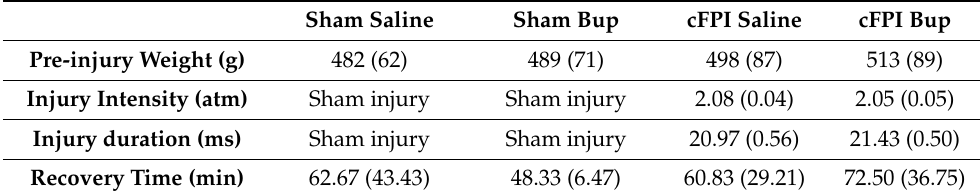
Table 1. Physiological readouts in sham or injured and saline or buprenorphine (Bup) treated animals prior to and 4 weeks following central fluid percussion injury